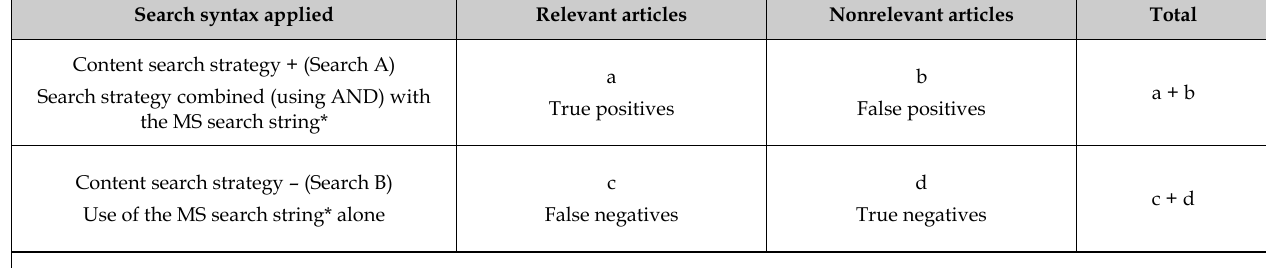
Table 1 Formulas used to calculate the sensitivity, specificity, precision, accuracy, and NNR of the content search strategy Search syntax